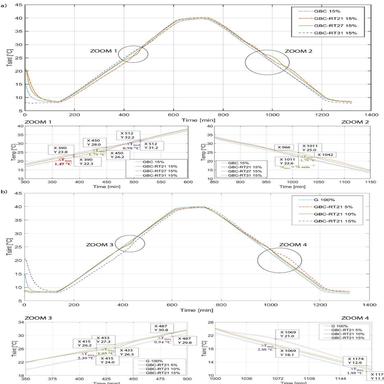
Ts,int of a) biochar compounds at 15 % and b) G and GBC-RT21 at the various percentage.